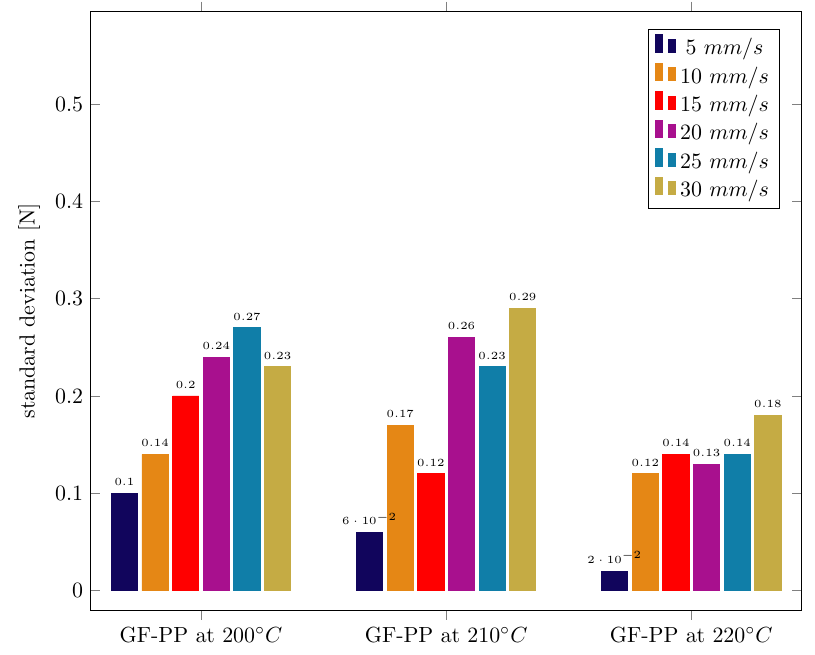
Figure 12. Comparison of standard deviations of mean values in the steady state process